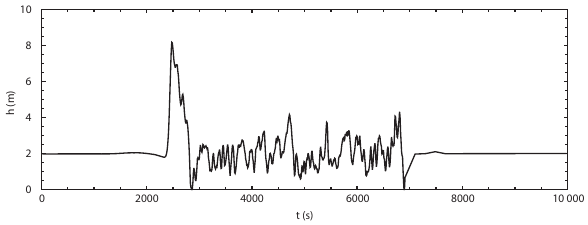
Fig. 6: STAV-2D results. The colors denote 4 cells that cover the location sampled by Andrade et al. (2003)